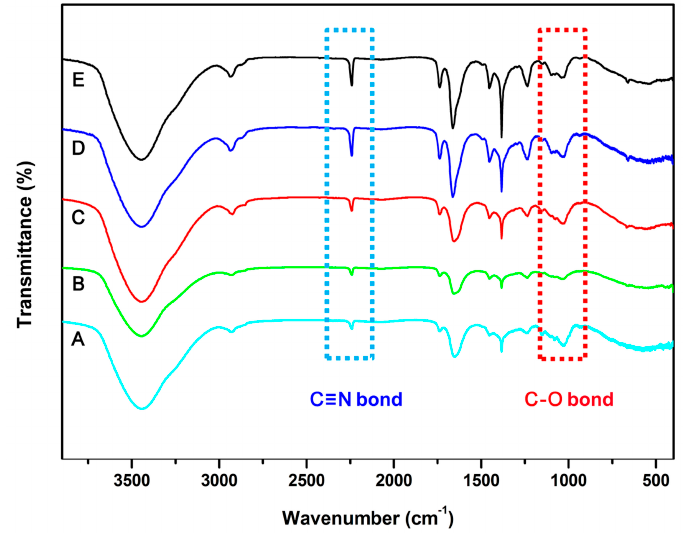
Figure 7. FTIR spectra of SG-Ag/PAN electrospun fibers prepared with different feed ratios of PAN and SG to Ag NPs: ( A ) 1:1:4, ( B ) 3:1:4, ( C ) 5:1:4, ( D ) 7:1:4, and ( E ) 9:1:4.